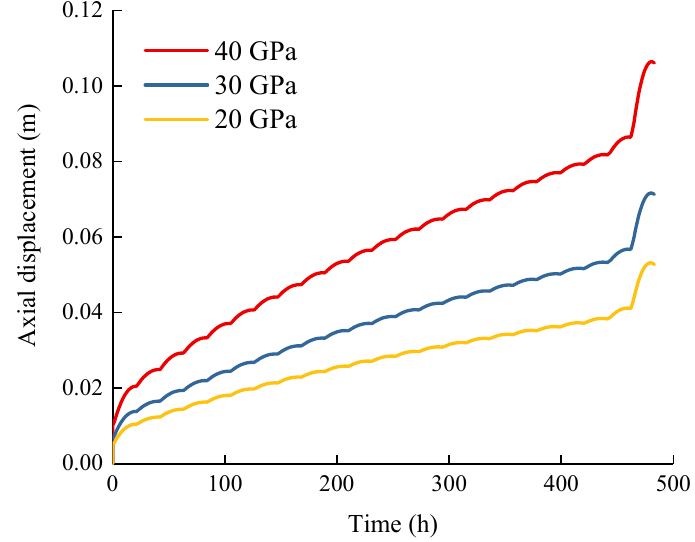
Figure 10. Effect of the initial Young’s modulus on the displacement at point A.